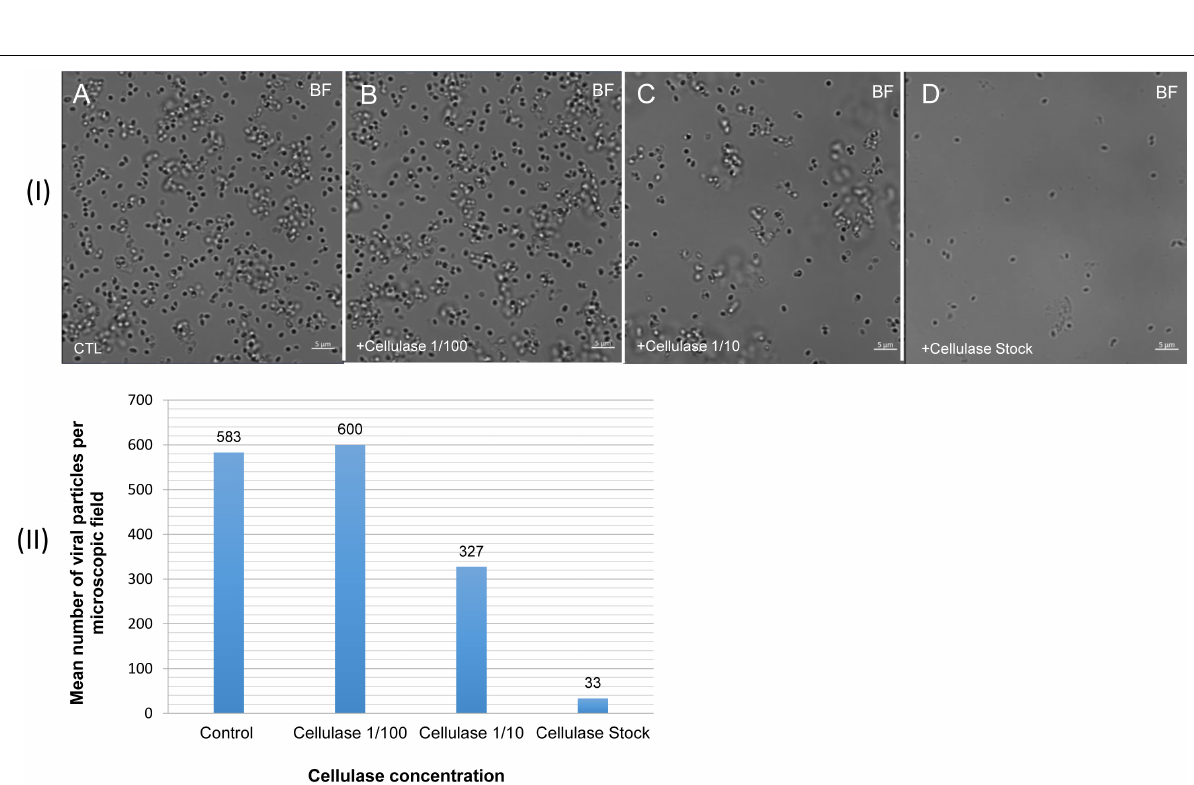
Frontiers in Microbiology |